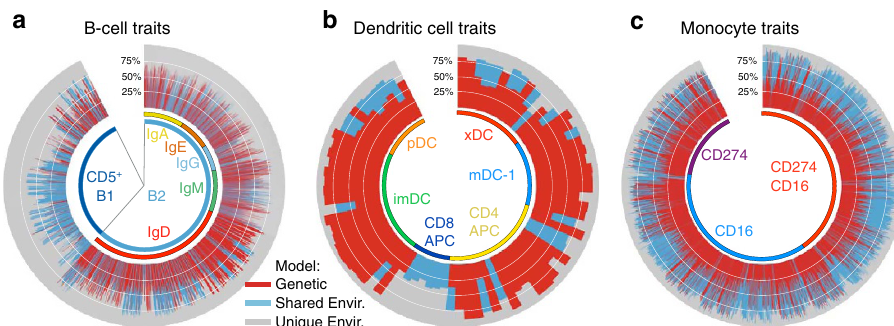
Figure 4 | Trait variation determination in non-T-cell subsets. ( a ) B-cell traits were arranged according to lineage (B1 or conventional B2) and among B2, by surface isotype expression (here, cells that co-express IgM and IgD are labelled as IgD; those that express only IgM are labelled as IgM). ( b ) DC traits are arranged by subset phenotype. ‘pDC’, plasmacytoid DC (CD11c (cid:2) CD123 þ ). ‘xDC’, DC co-expressing CD11c and CD123. All others are myeloid DC (mDC, CD11c þ CD123 (cid:2) ), including mDC-1 (CD1c (cid:2) CD16 (cid:2) ), antigen-presenting cells for CD4 T cells (‘CD4 APC’, CD1c þ ), antigen-presenting cells for CD8 Tcells (‘CD8 APC’, CD141 þ ) and inflammatory mDC (‘imDC’, CD1c (cid:2) CD16 þ ). ( c ) Monocyte traits are divided by the coordinate expression of CD16